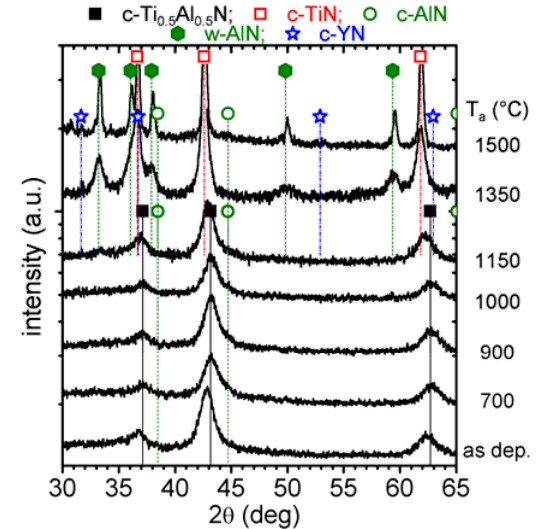
Figure 5. XRD evolution of single-phase c-Ti T up to 1500 a